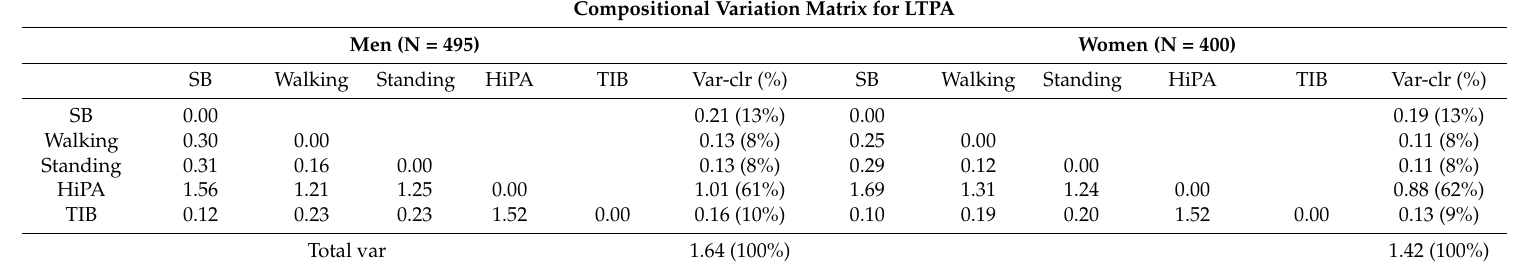
Table 3. Compositional variation matrix for time spent on occupational physical activities and leisure time physical activities. Compositional Variation Matrix for OPA Men (N = 495) Women (N = 400) Walking Standing Sitting HiPA Var-clr (%) Walking Standing Sitting HiPA Var-clr (%) Walking 0.00 0.35 (22%) 0.00 0.19 (12%) Standing